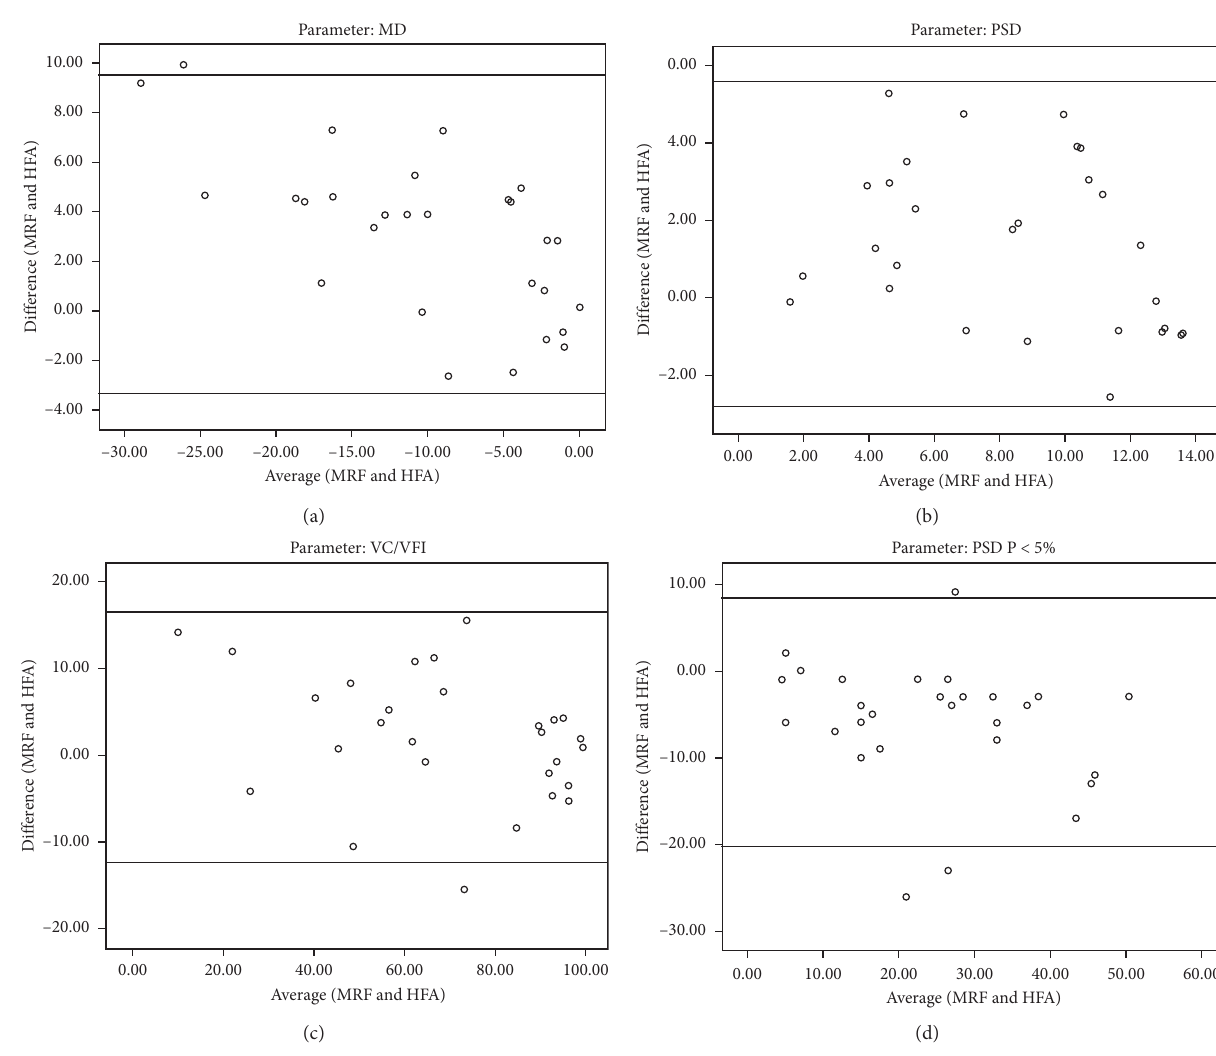
Figure 5: Bland–Altman plots showing agreement in (a) mean deviation (MD), (b) pattern standard deviation (PSD), (c) visual field index (VFI)/visual capacity (VC), and (d) the number of depressed points with P < 5% on PSD probability plot between Humphrey Field Analyzer (HFA) 24-2 Swedish Interactive Threshold Algorithm (SITA) Standard and Melbourne Rapid Fields